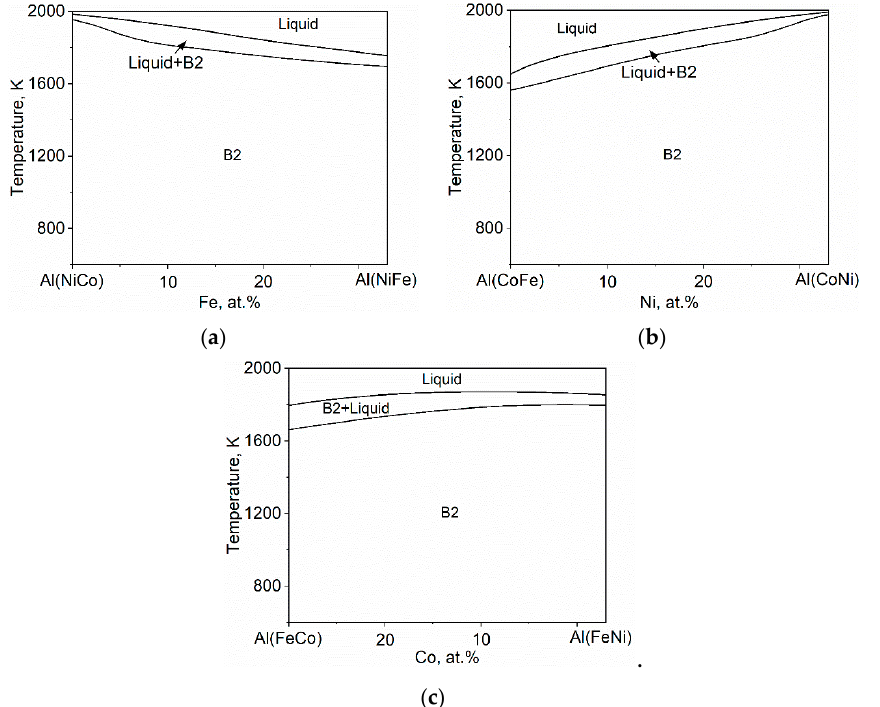
Figure 2. Calculated isopleth sections in the Al(Co,Fe,Ni) system as a function of ( a ) Fe; ( b ) Ni; ( c ) Co.